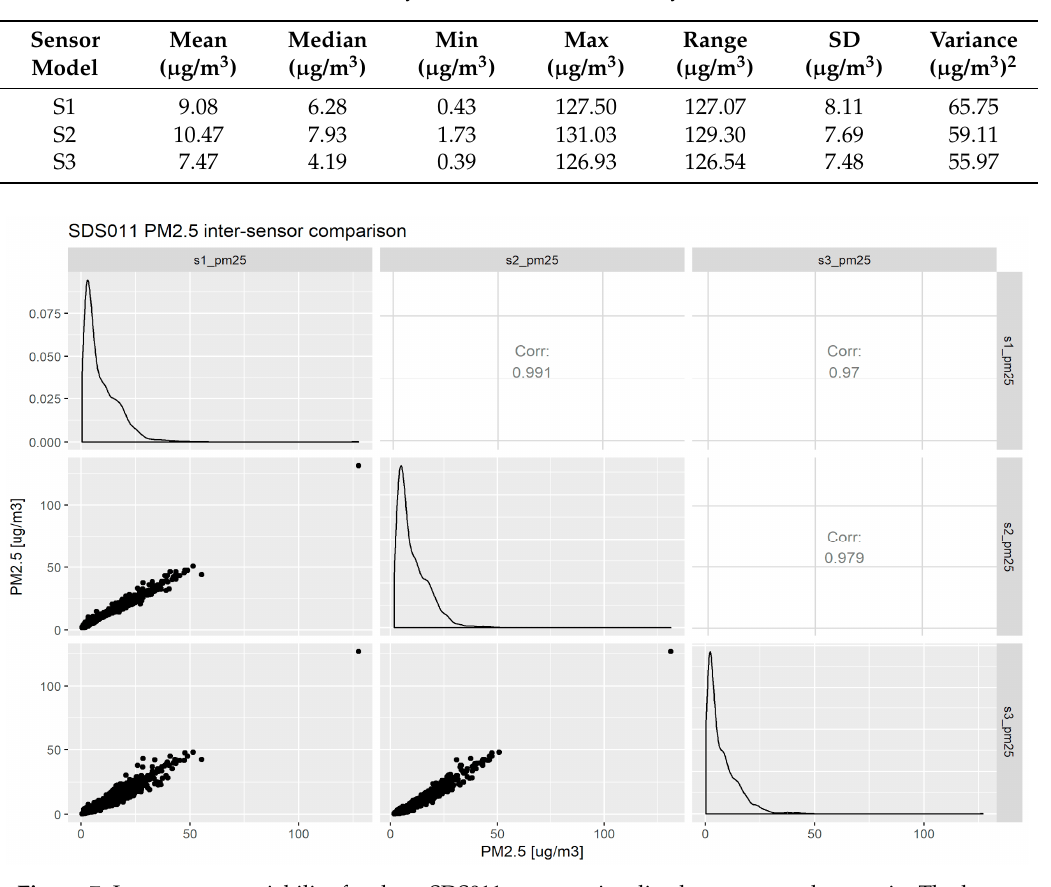
Table 4. The statistical summary for inter-sensor variability for three SDS011 sensors.